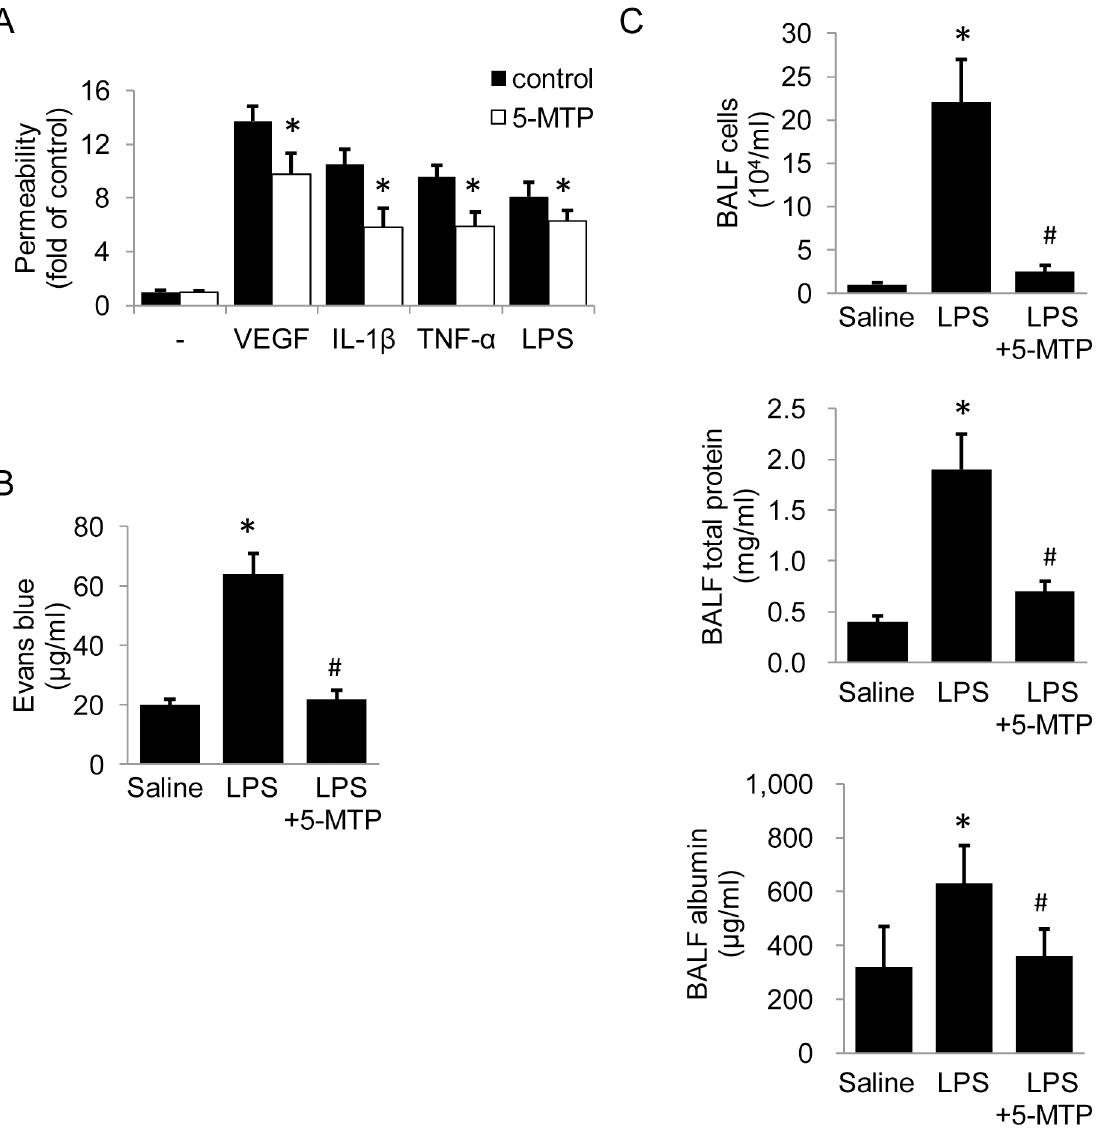
Fig 2. 5-MTP protects barrier function in vitro and in vivo. (A) Analysis of 5-MTP (100 μ mol/L) effect on endothelial permeability by an in vitro permeability assay with FITC-labeled dextran. Each bar denotes mean ± SD of three independent experiments. * indicates P < .05. (B) Mice were injected with L-5-MTP (23.4 mg/kg) for 30 minutes prior to challenge with LPS (60 mg/kg) for 24 hours. Evans blue dye was used to analyze pulmonary microvascular permeability as described in Methods. The error bars denote mean ± SD (n = 8 mice/group). * indicates P < .05 compared to control and # indicates P < .05 compared to LPS group. (C) Mice were injected with L-5-MTP (23.4 mg/kg) for 30 minutes prior to challenge with LPS (60 mg/kg) for 24 hours. BALF was collected by lavage. Total number of leukocytes was determined by cell counting. Total protein and albumin were analyzed. The error bars denote mean ± SD (n = 5 mice/ group). * indicates P < .05 compared to control and # indicates P < .05 compared to LPS